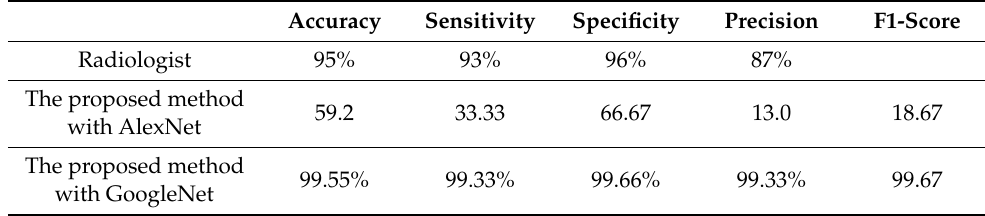
Table 1. Quantitative